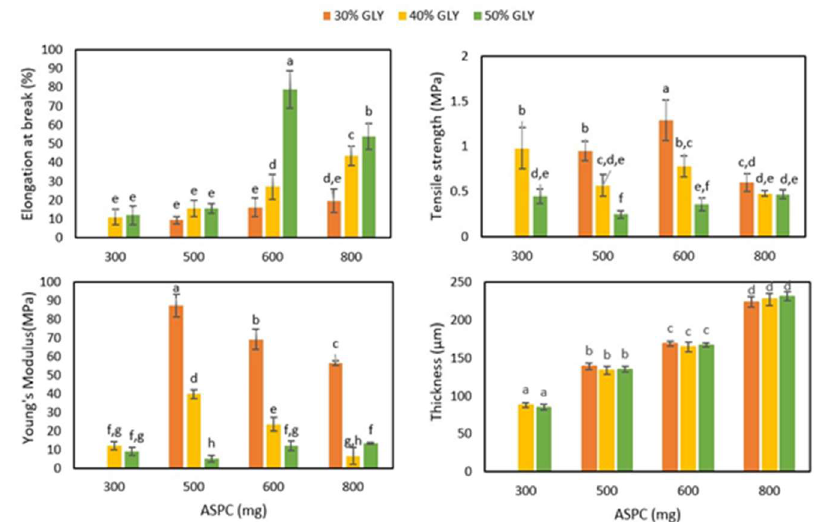
Figure 5. Thickness and mechanical properties of argan seed protein concentrate (ASPC)-based films prepared with film-forming solutions containing the indicated ASPC amounts and glycerol (GLY) concentrations. Different small letters (a–h) indicate significant differences among the values reported ( p < 0.05). Further experimental details are described in the text.